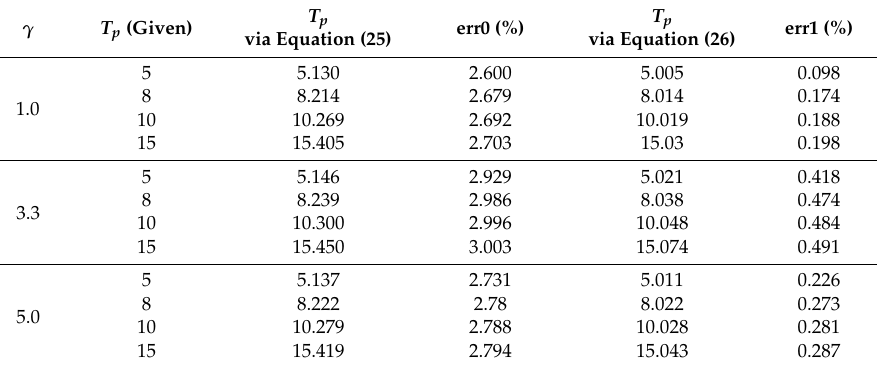
Table 1. Spectral peak period calculation for the theoretical spectra.